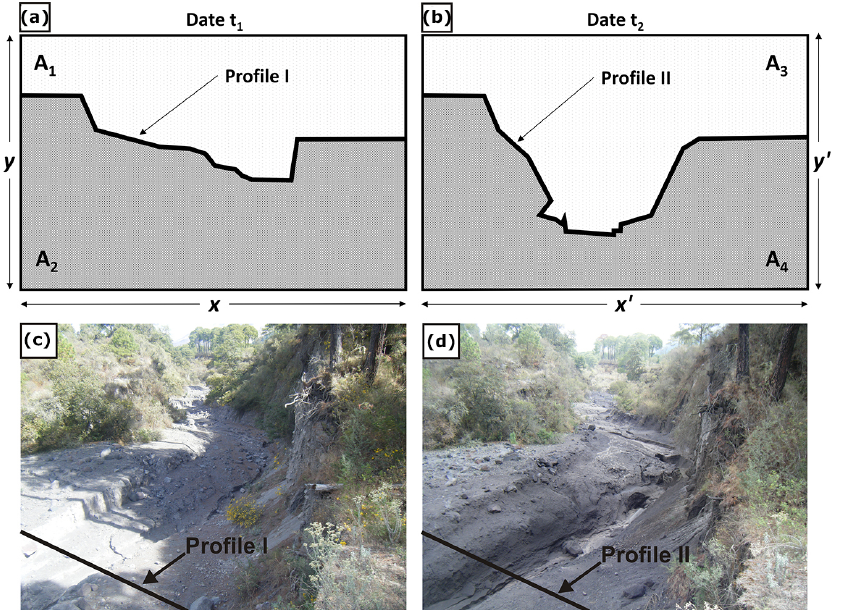
Figure 3. Graphic representation of the parameters used in the methodology to determine the E (erosion) and D (deposition) rates within the profiles; and photos taken at the monitoring site of Montegrande ravine, before and after the 11 June 2013 lahar. (a) Representation of the topographic profile during date i, and the parameters needed to determine AT = A1 + A2. (b) Representation of the topographic profile changed during date ii, and the variation of the parameters needed to determine the areal values. (c) Image of the active channel being monitored on 11 June 2013. (d) Image of the channel on 12 June